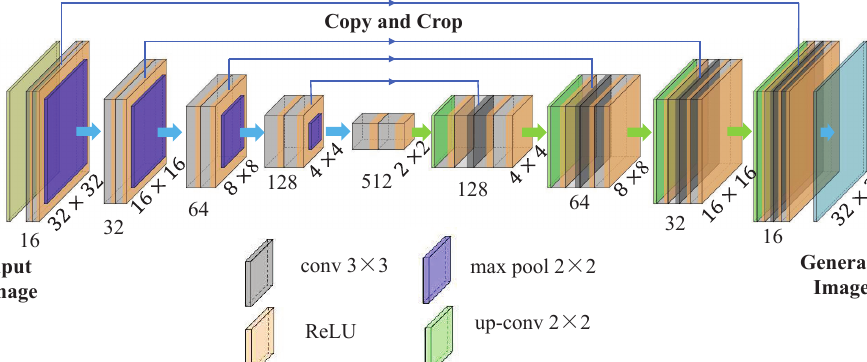
Figure 3. Generator architecture: the number of channels is provided at the bottom of the box, and the size of the image is marked on the right side of the